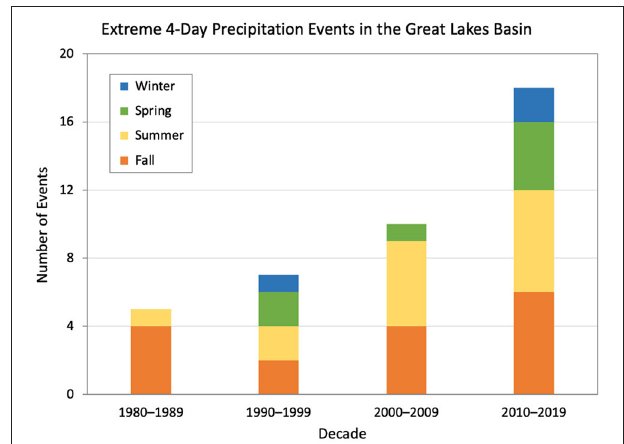
FIGURE 9 | Number of the 40 largest basin-wide 4-day precipitation events by decade from 1980–1989 to 2010–2019 delineated by season. Precipitation is calculated from the MERRA-2 reanalysis and averaged over the Great Lakes Basin.